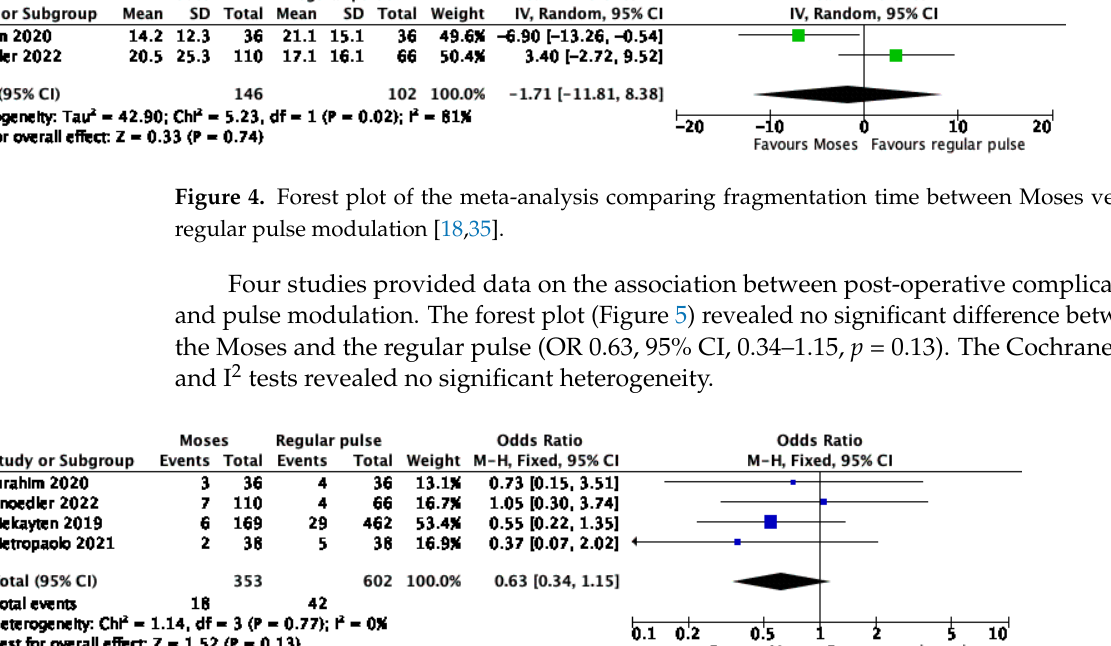
Figure 5. Forest plot of the meta-analysis comparing post-operative complications between Moses versus regular pulse modulation [18,35,37,38].